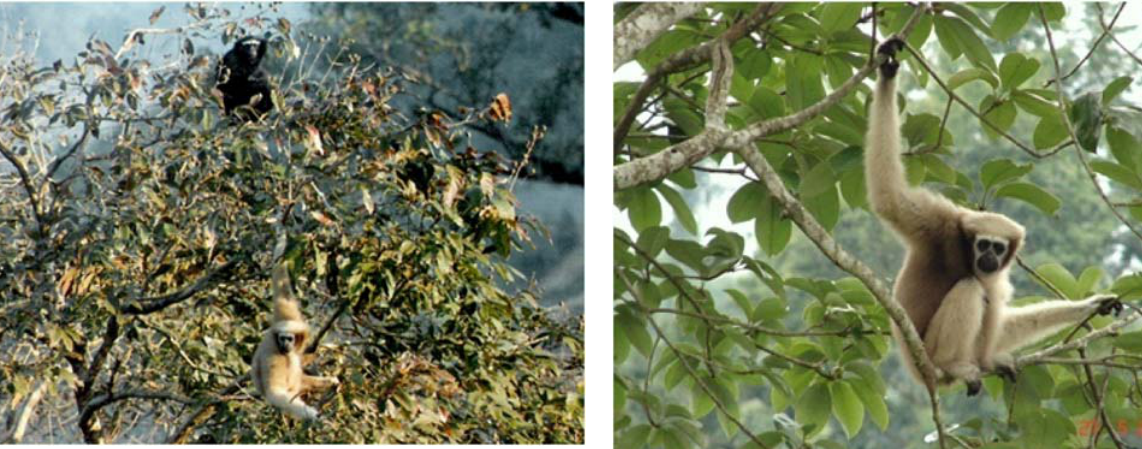
1. A pair of adult male and female gibbons feeding.